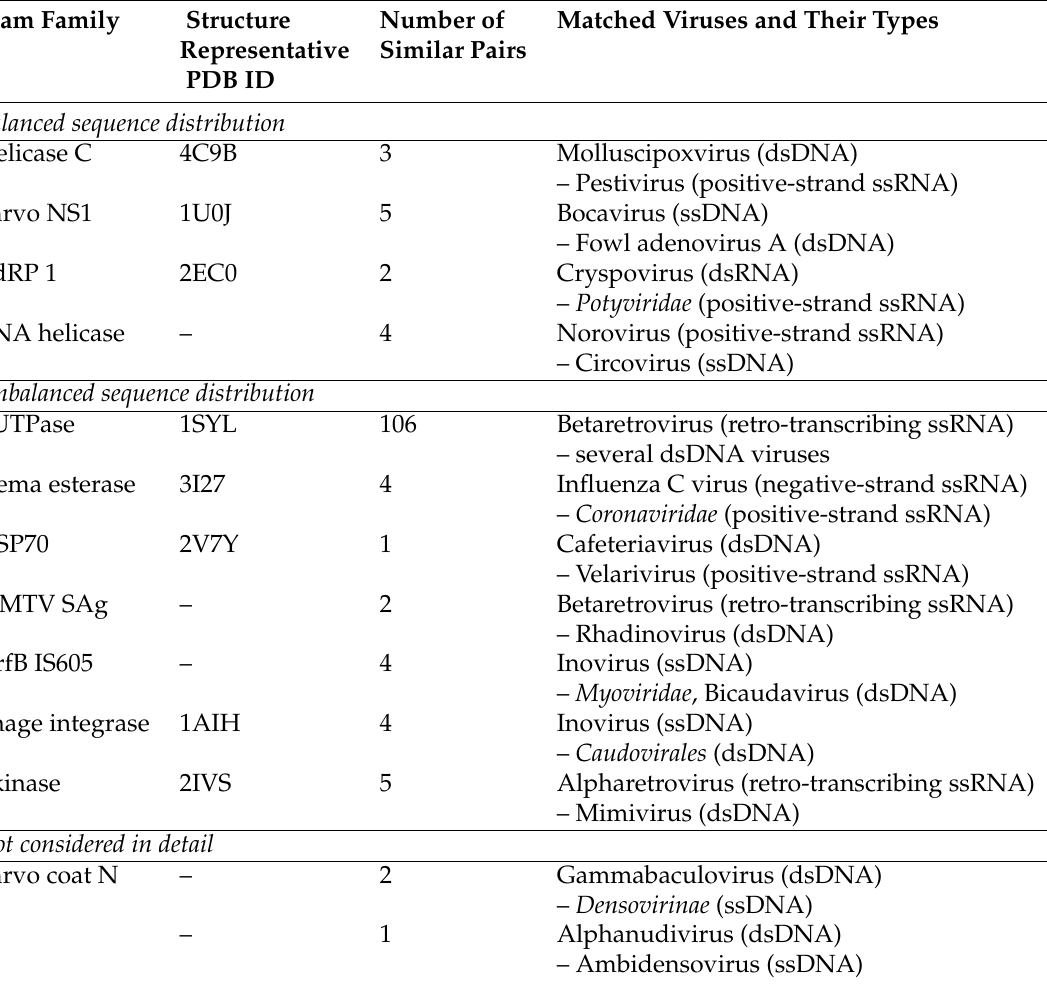
Table 1. Protein families containing proteins with significant sequence similarity from viruses from different Baltimore